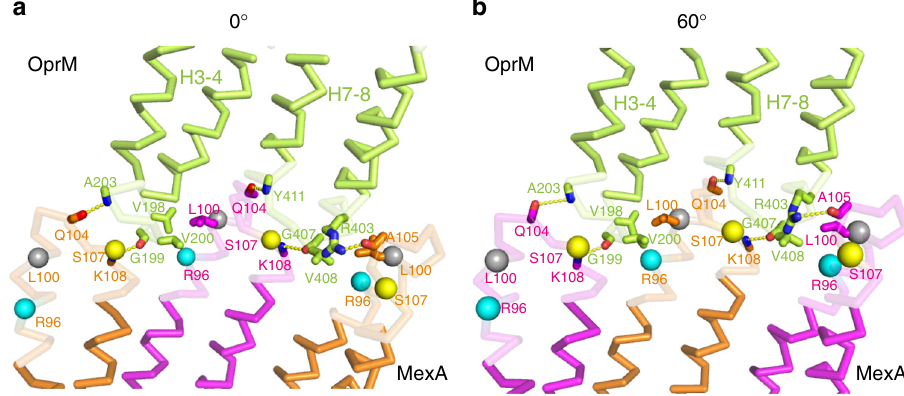
Fig. 2 Interaction between OprM and MexA. Close-up views of the α -hairpin of OprM (shown in lemon) and the α -hairpin of MexA [shown in magenta (SC protomer) or orange (LC protomer)] in the 0° state ( a ) or 60° state ( b ). Previously proposed RLS motifs are shown as balls colored in cyan (R96), gray (L100), and yellow bond with the main chain of A105 in MexA. These results suggest that the two modes of binding between MexA and OprM do not differ signi fi cantly. In addition, the number of particles in the 3D classi fi cation of both states was not much different (Supple- mentary Fig. 3), and it might be considered that these two binding modes exist equally within bacterial cells.